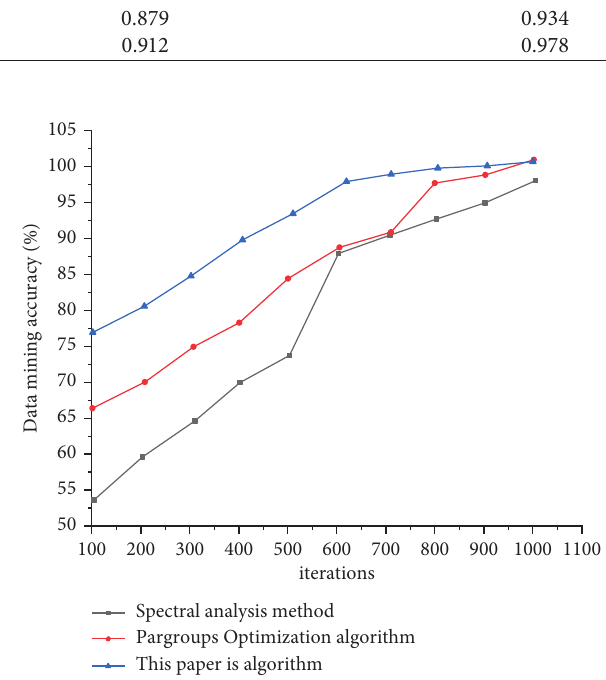
Figure 2: Comparison of mining accuracy performance.